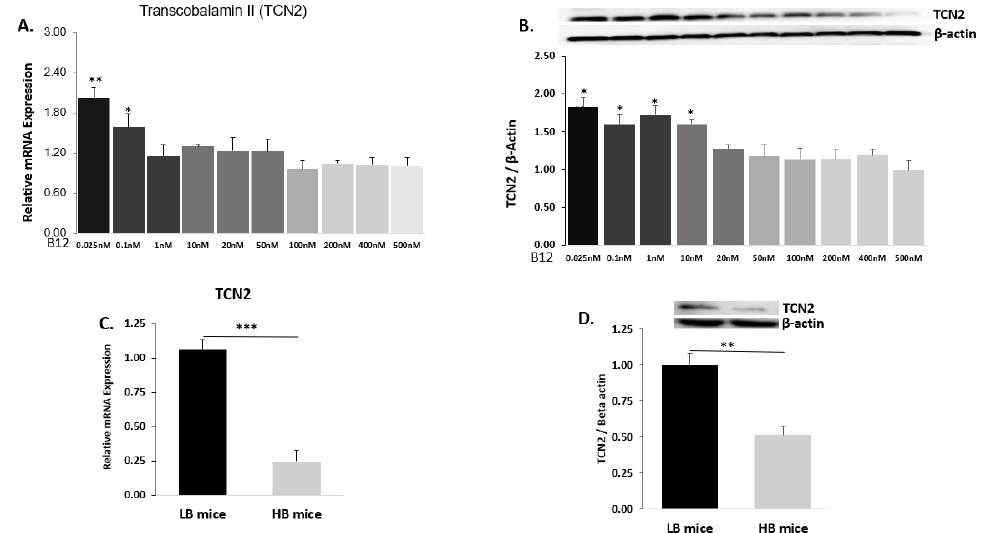
Figure 3. B12 transporter (transcobalamin II, TCN2) mRNA expressions and protein levels in Hep G2 and liver tissues: ( A ) The mRNA expression of TCN2 in Hep G2 normalized to 18S rRNA endogenous control and ( B ) protein level of TCN2 related to β -actin in Hep G2 at ten different B12 media concentrations (500 nM (control), 400 nM, 200 nM, 100 nM, 50 nM, 20 nM, 10 nM, 1 nM, 0.1 nM and 0.025 nM). ( C ) The TCN2 mRNA expression in liver tissues of HB and LB mice normalized to L19 endogenous control and ( D ) represents the levels of B12 transporter TCN2 protein related to β-actin in HB and LB groups of mice. The data are representative of mean ± SEM ( n = 6), and * indicates significance compared to the control; * p < 0.05, ** p < 0.01, *** p < 0.001.